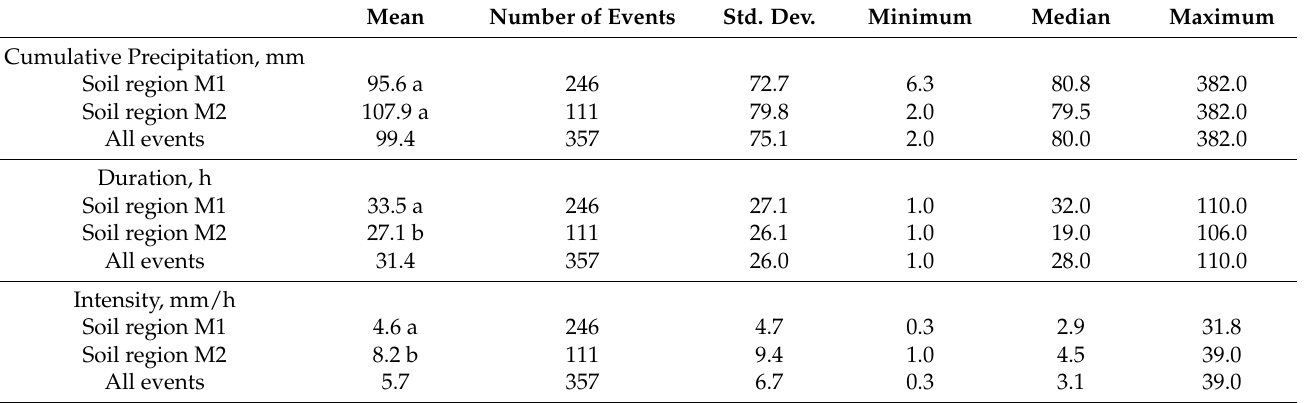
Table 3. Descriptive statistics of the rainfall events triggering landslides in the two soil regions (M1 and M2) and in the entire study area. Mean values followed by different letters are significantly different at the p < 0.05 level, according to ANOVA